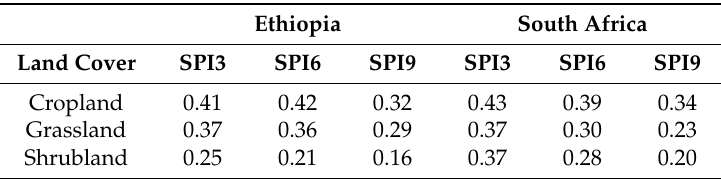
Figure 11. Spatial variation of Pearson correlation coefficients ( top ) and p -value ( bottom ) of RZSM anomalies with meteorological-based drought indices. Table 3. The Pearson’s correlation coefficient computed between agricultural-based drought indices and meteorological-based drought indices for different land cover